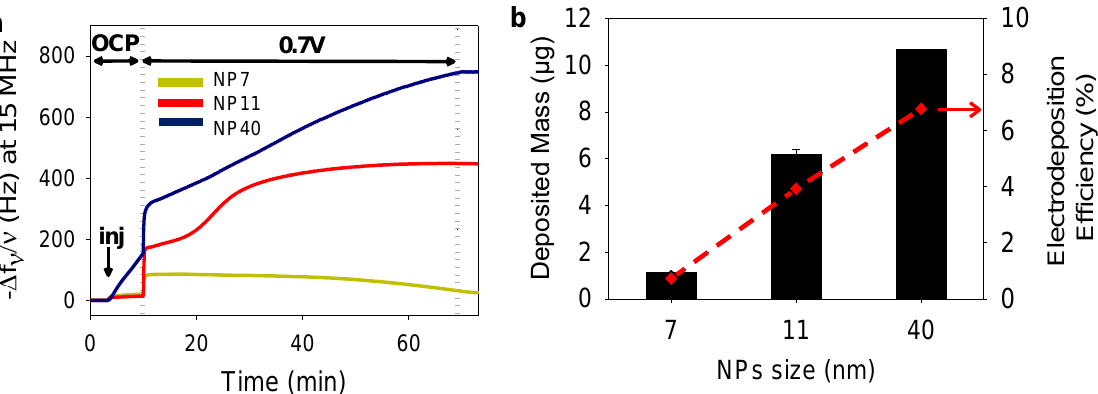
Figure 3. Electrodeposition of NPs with different sizes ( a ) Evolution of the normalized frequency shift of NPs/FcOH solutions, measured by EC–QCM, with NP7, NP11, and NP40, as a function of time during the application of 0.7 V. No electrical stimulus is applied during the OCP (open circuit potential). The arrow “inj” indicates the time of injection of the solution. ( b ) Deposited mass (µg), calculated from EC-QCM, using a geometric surface of 0.8 cm², and the corresponding electrodeposition efficiency (red diamond) for the different NP sizes.